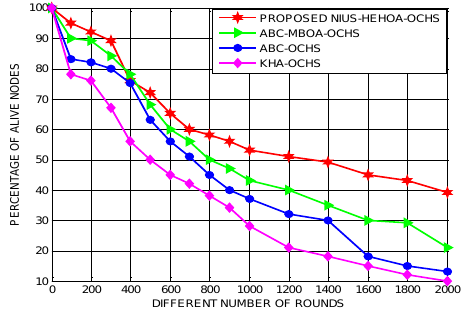
Figure 1. Proposed NIUS-HEHOA-OCHS: Percentage of Alive nodes under different rounds The number of dead nodes in the network obtained by the proposed NIUS-HEHOA-OCHS scheme is determined to increase with an increase in the number of rounds. But, the number of dead nodes reaches the maximum value of 100, only in the round of 2000. While, the benchmarked such as ABC-MBOA-OCHS , ABC- OCHS and KHA-OCHS schemes reach the same point at 1920, 1950 and 1980 rounds, respectively.Hence, the percentage of dead nodes in the network facilitated by the planned NIUS-HEHOA-OCHS scheme is also proved to be significant by 11%, 14%, 16% and 19%, significant to the benchmarked ABC-MBOA-OCHS , ABC-OCHS and KHA-OCHS